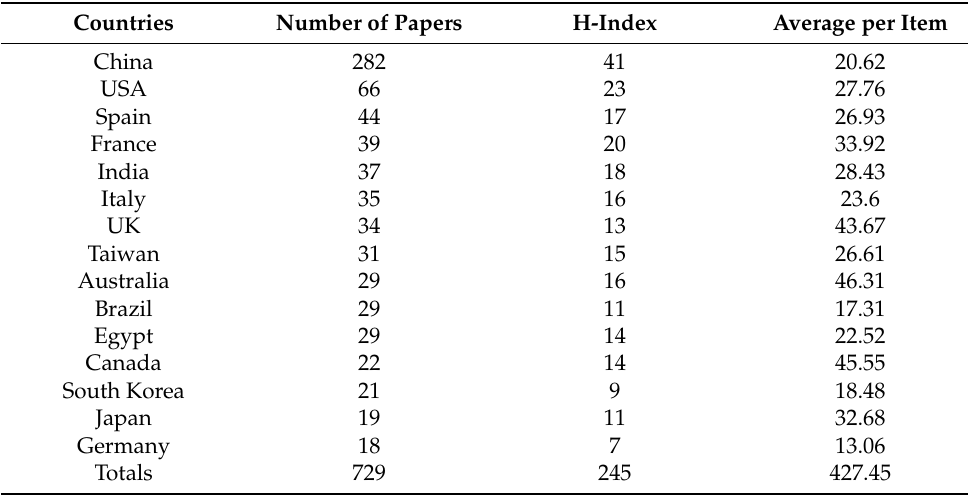
Table 1. Statistics of related publication in top fifteen countries.